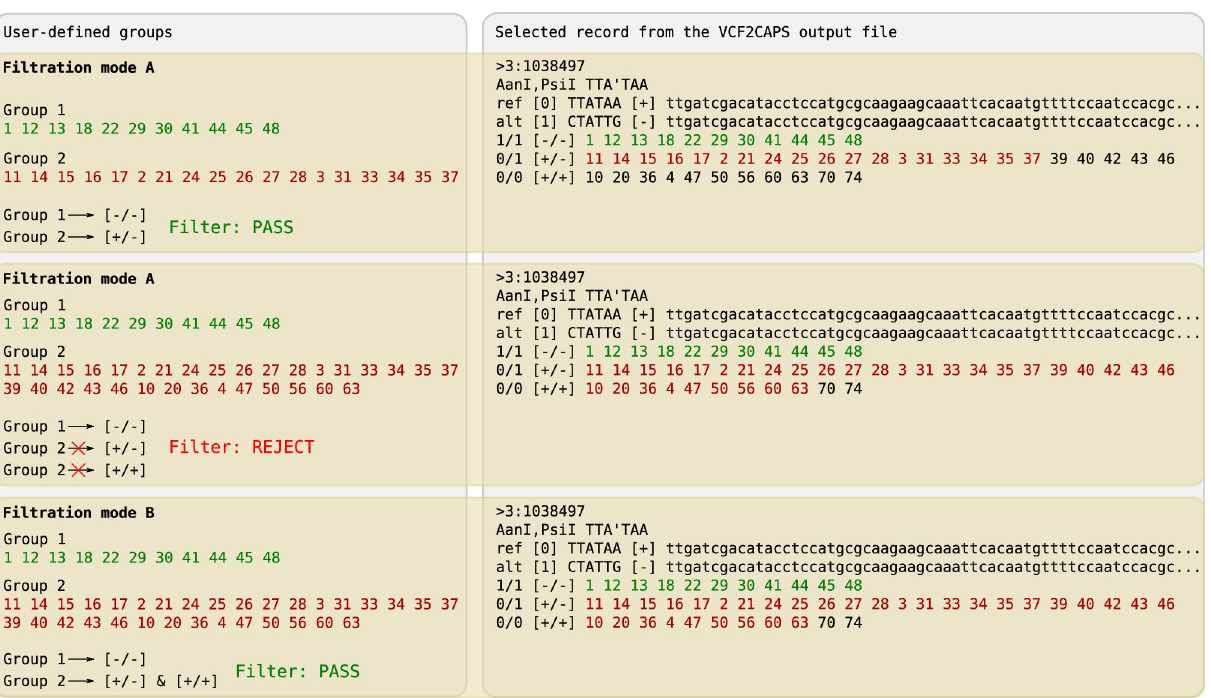
Fig 5. Filtration of CAPS markers with desired distribution of analyzed individuals among detected genotypes (filtration by groups).